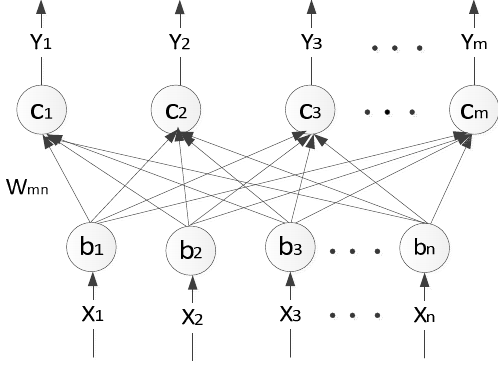
Figure 3. Network topology of Restricted Boltzmann Machine.